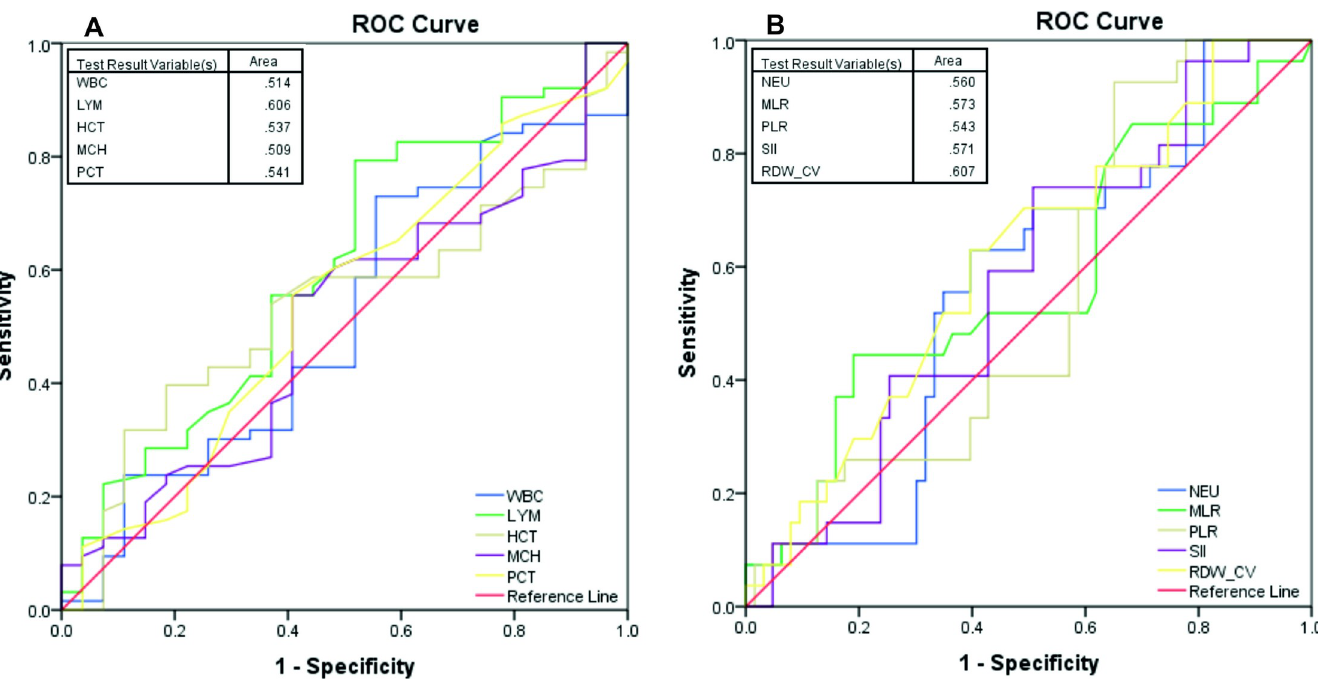
Fig 3. Receiver operating characteristic (ROC) curves for the representative single hematological parameters. (A) The analysis of AUCs (Area under the curve) for WBC, LYMF, HCT, MCH and PCT and (B) NEU, MLR, PLR, SII and RDW-CV indicated no statistically significant results, except LYM. Abbreviations: AUC: Area Under the Curve; ROC: Receiver Operating Characteristic; HCT: hematocrit; LYM: lymphocytes; MCH: mean corpuscular hemoglobin; MLR: monocyte-to-lymphocyte ratio; NEU: neutrophils; RDW-CV: red cell distribution width, coefficient variation; PCT: plateletcrit; PLR: platelet-to-lymphocyte ratio; SII systemic immune- inflammation index and WBC: white blood cell